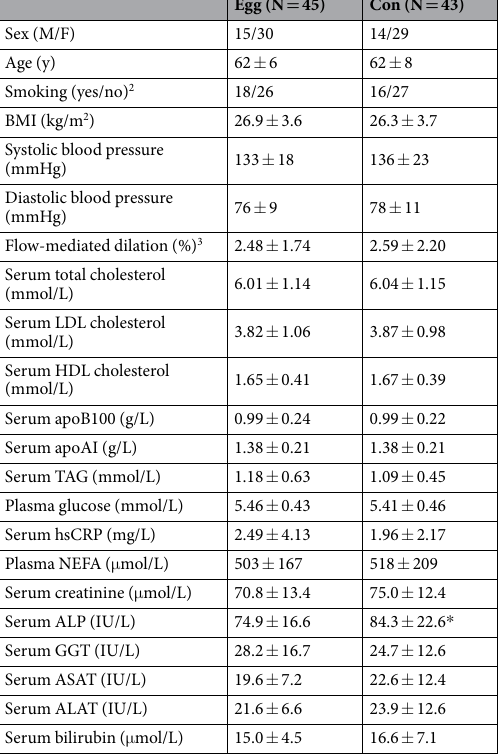
Table 1. Baseline characteristics, serum lipids and (apo)lipoproteins, markers for cholesterol metabolism and liver- and kidney function of study participants within the egg-drink (Egg) and control (Con) groups 1 . 1 Values are means ± SDs. * Different from Con, P < 0.05. ALAT; Alanine transaminase, ALP; Alkaline phosphatase, ASAT; Aspartate transaminase, CRP; high-sensitivity C-reactive protein, GGT; Gamma- glutamyltranspeptidase, NEFA; non-esterified fatty acids. 2 Smoking status of one subject in the Egg group was not provided. 3 Flow-mediated dilation results are shown for N = 42 in the Egg group and N = 39 in the Con